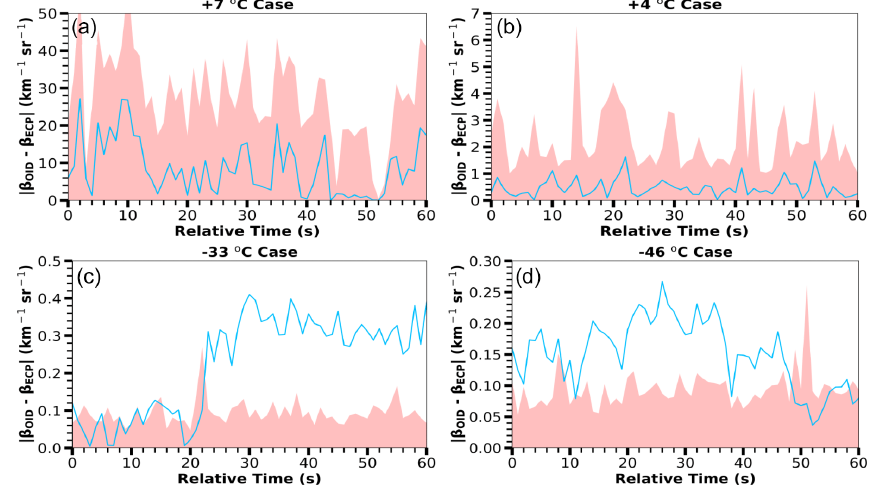
Figure 6. Plots showing 1Hz time series of the absolute difference (blue line) between the Optical Ice Detector (OID) and external cloud probes (ECP) backscatter coefficients for the four case study segments (Table 2). The shadowed region top represents 3 standard deviations of OID and ECP backscatter coefficients, determined using Eq.